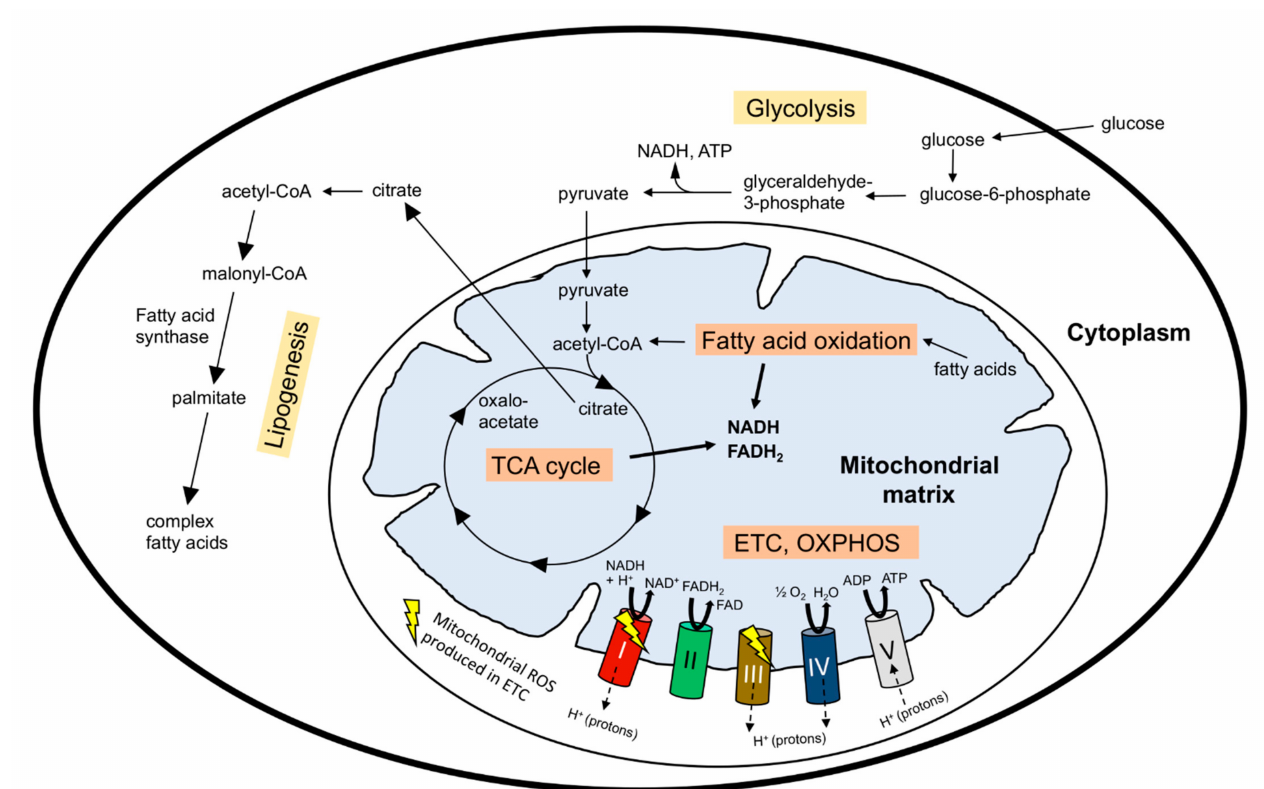
Figure 1. Simplified depiction of the cellular metabolic pathways discussed in this review. Glycolysis converts glucose into pyruvate that is transported into mitochondria and converted to acetyl-CoA. Acetyl-CoA is also produced during fatty acid oxidation (FAO) in the mitochondrial matrix. Acetyl-CoA enters the tricarboxylic acid (TCA) cycle that produces the substrates NADH and FADH 2 (for respiratory complex I and II, respectively) required for oxidative phosphorylation (OXPHOS). Electron transport during respiration is coupled to proton (H + ) export from the mitochondrial matrix to the inter-membrane space. This generates an electrochemical gradient ∆ ψ m where the H + concentration is higher in the inter-membrane space than in the matrix. When H + flow back into the matrix through ATP synthase (complex V), the energy of this gradient is used to produce ATP. During OXPHOS, electrons leak at respiratory complex I and III and react with molecular oxygen to produce ROS (superoxide, which is converted to H 2 O 2 ). In addition to the TCA cycle, NADH and FADH 2 are produced during FAO. Citrate produced in the TCA cycle exits mitochondria and is converted back to acetyl-CoA in the cytoplasm, where it is used to generate complex fatty acids through de novo lipogenesis. For FAO, complex fatty acids must be transported into the mitochondrial matrix via a carnitine shuttle system and two distinct transporters located in the outer and inner mitochondrial membrane. For simplicity, transporter proteins for various molecules are not shown in the figure. Arrows with dashes indicate the direction of proton (H + ) transport/flow between the mitochondrial matrix and the intermembrane